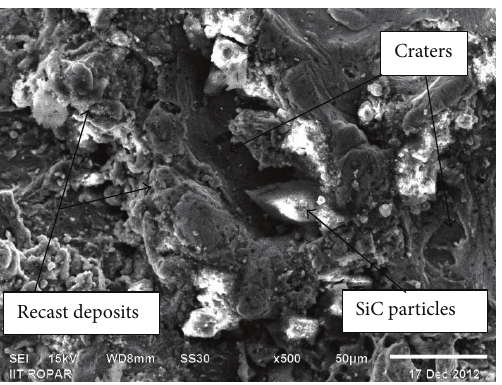
Figure 21: SEM photograph of machined surface (9Amp, 60V, 𝑇 on - 90 𝜇 s, and 𝑇 off -90 𝜇 s).